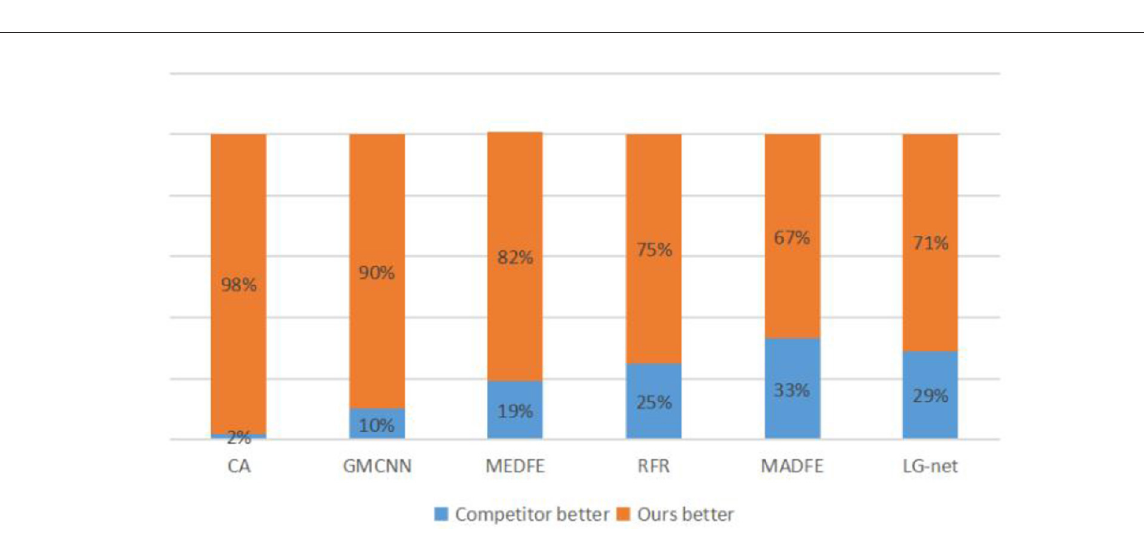
FIGURE8 Statistical results of a user study on the CelebA-HQ data set. The value shows the percentage of each method chosen as the better